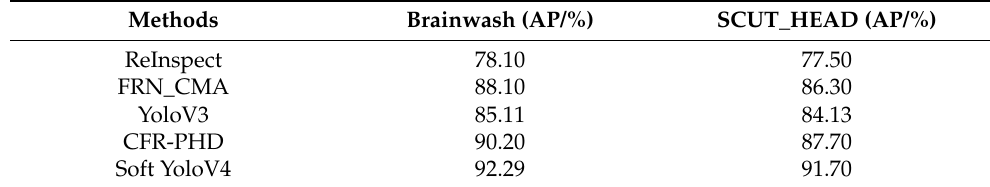
Table 2. Experimental results obtained on Brainwash and SCUT_HEAD.